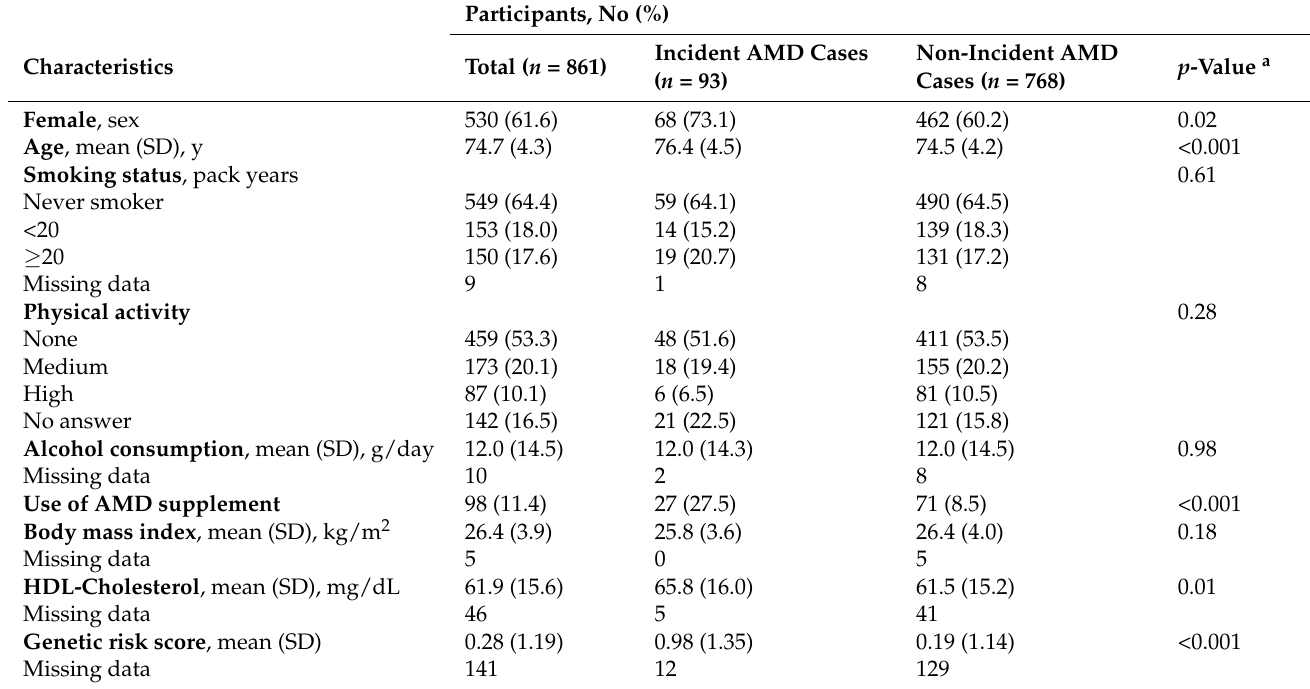
Table 1. Baseline population characteristics according to AMD status in the Alienor Study ( n = 861, 2001–2017).